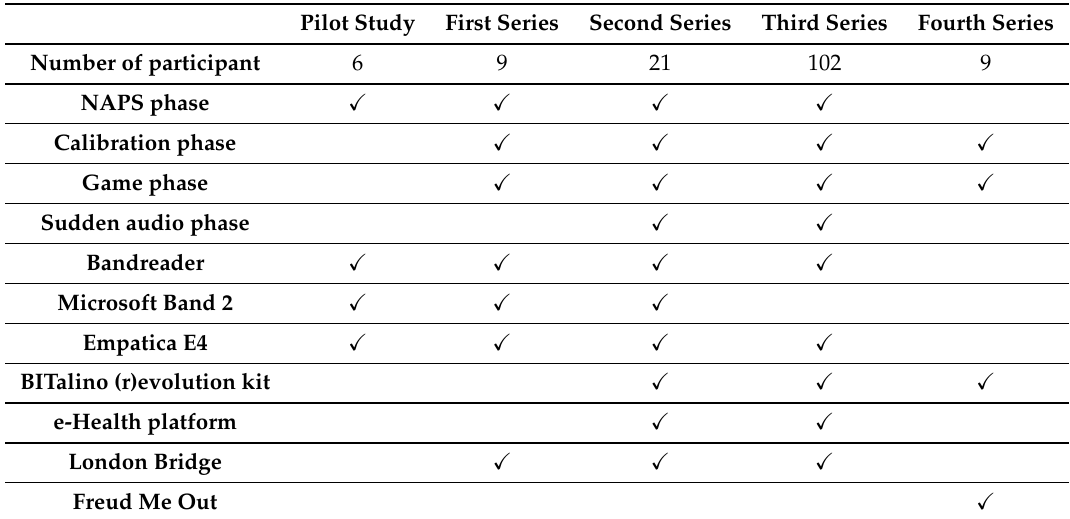
Table 2. Experiments series on Affective Computing. NAPS, Nencki Affective Picture